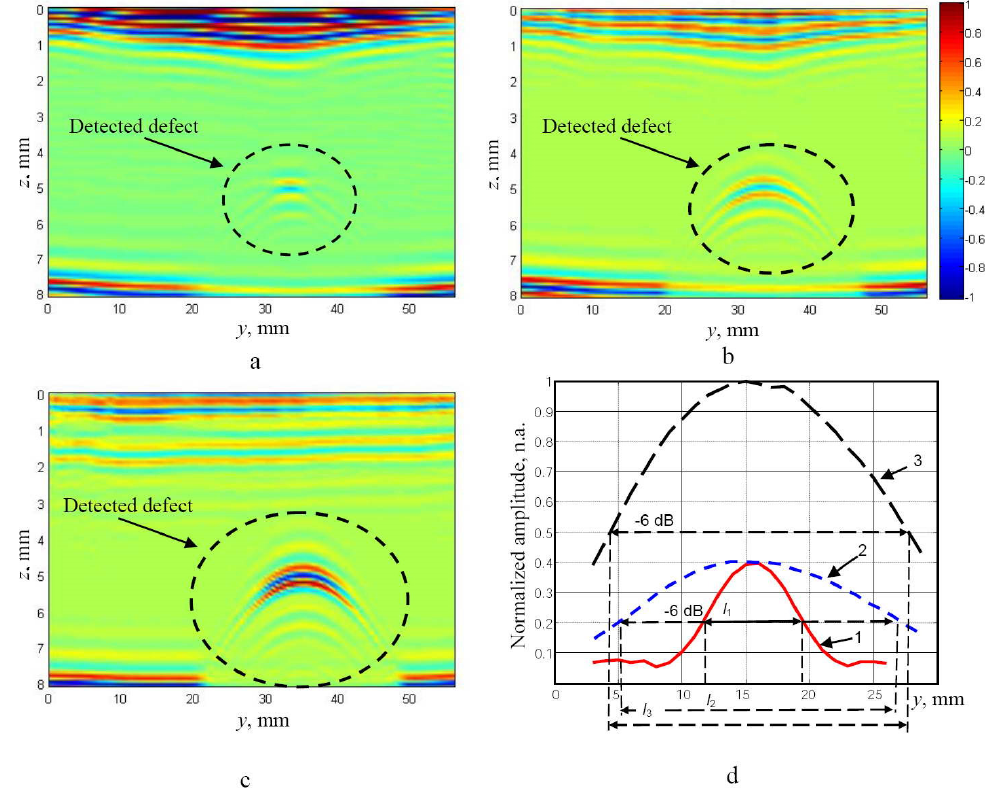
Figure 6. Experimentally obtained B-scan images: ( a ): in the case without focusing, ( b ): focusing the ULPAT in the active aperture (azimuth cross-section) only, ( c ): dual focused beam in the elevation and azimuth cross-sections. The peak amplitudes (normalized) of the reflections from the artificial defect ( d ): 1—without focussing, 2—with focusing in the azimuth cross-section, 3—with focusing in the elevation and azimuth cross-sections. Widths of the detected defect (marked by l 1 , l 2 and l 3 ) are estimated at the − 6 dB level in respect of maximums of the normalized amplitudes for different configurations of beam focusing.